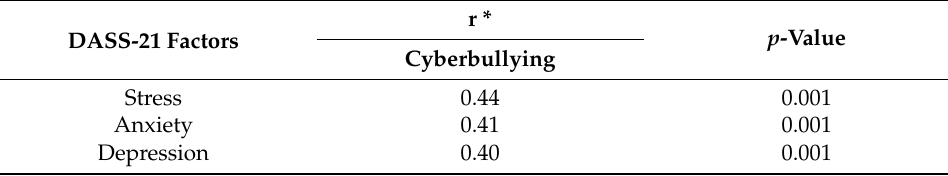
Table 4. Correlation between CBS-M and DASS-21 factors ( n =